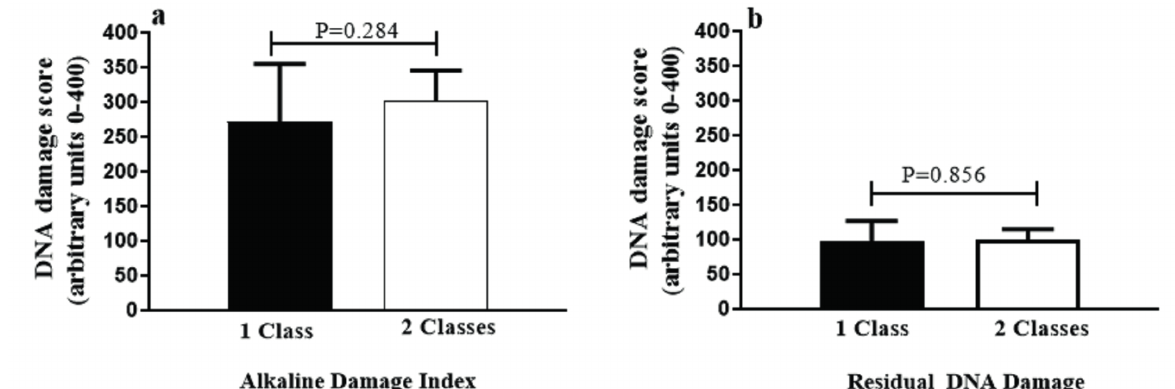
Figure 4 - Alkaline damage index and residual damage of lung cancer patients stratified by groups undergoing treatment with 1 or 2 classes of chemotherapeutic RDugs. 1 class: number of subjects = 5; 2 classes: number of subjects =19; DI: Damage index. a : Frequency of baseline damage index; b : Frequency of residual damage after incubation with MMS. Student’s t -test was performed to compare the alkaline damage index and residual damage between the